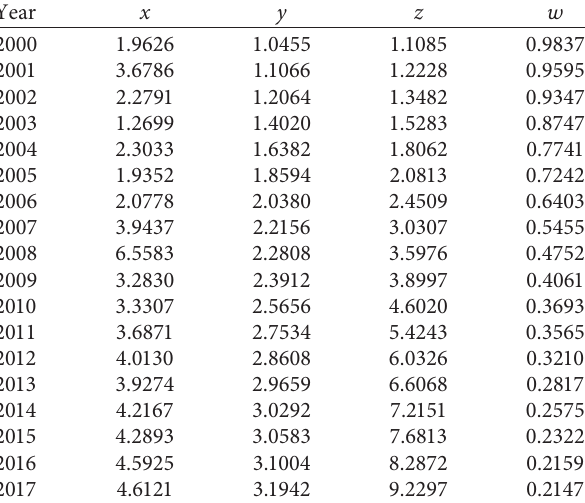
Table 2: Statistics on energy reduction, energy consumption, GDP, and environment in